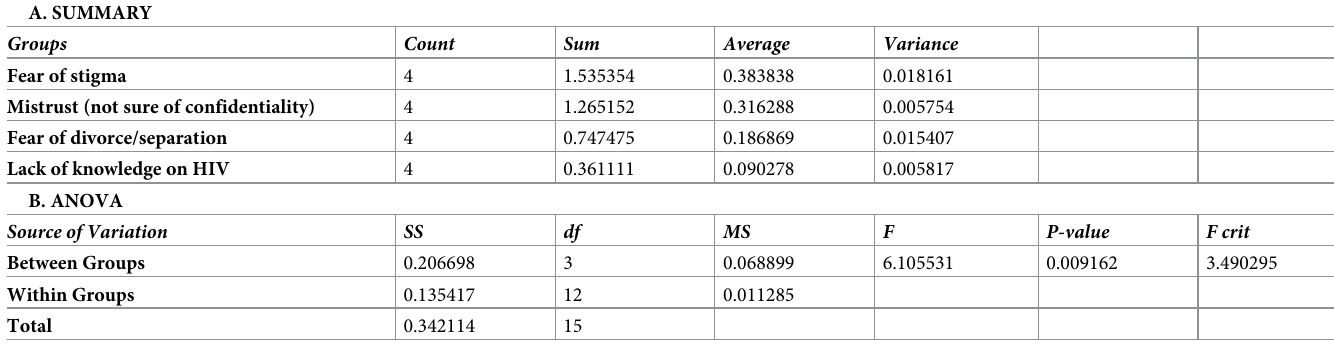
Table 2. One way ANOVA test for challenges of